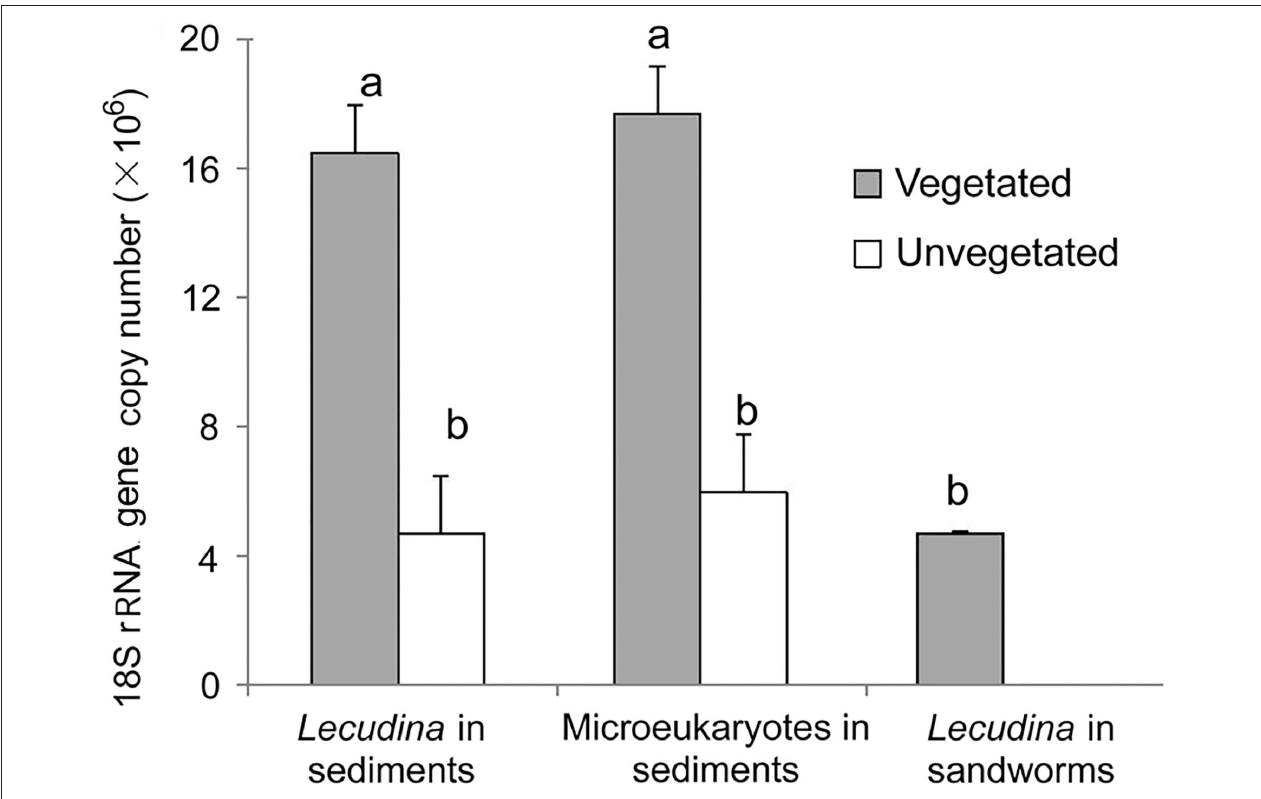
FIGURE 5 | Comparisons of 18S rRNA gene copy numbers of Lecudina polymorpha and all microeukaryotes between the vegetated and unvegetated sediments, and in the whole-body tissue mixture of a sandworm species. Different labeling letters (a and b) indicate that the mean values of vegetated and unvegetated samples were significantly different by t-